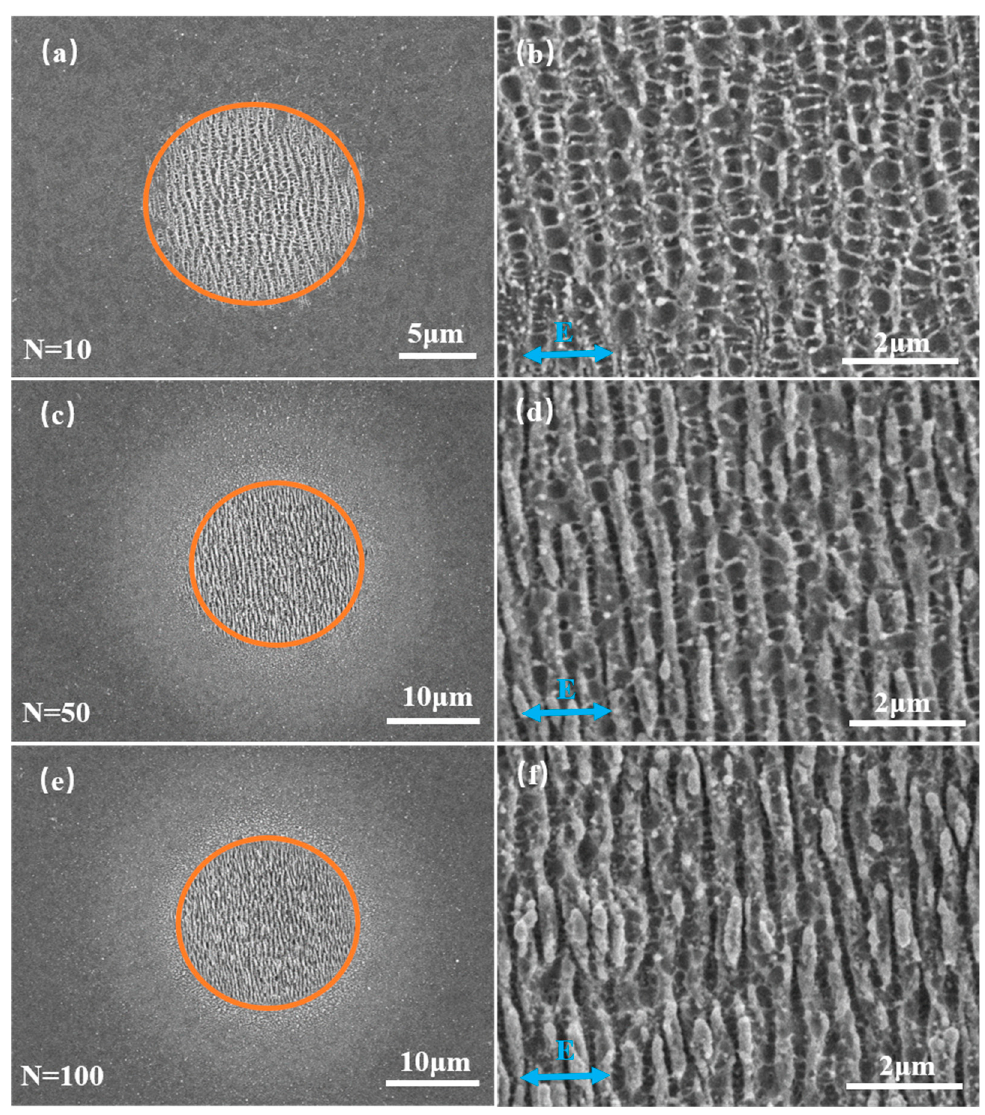
Figure 2. SEM images of ablation shapes and subwavelength ripples on titanium obtained at different femtosecond pulses: ( a , b ) N = 10, ( c , d ) N = 50, and ( e , f ) N =